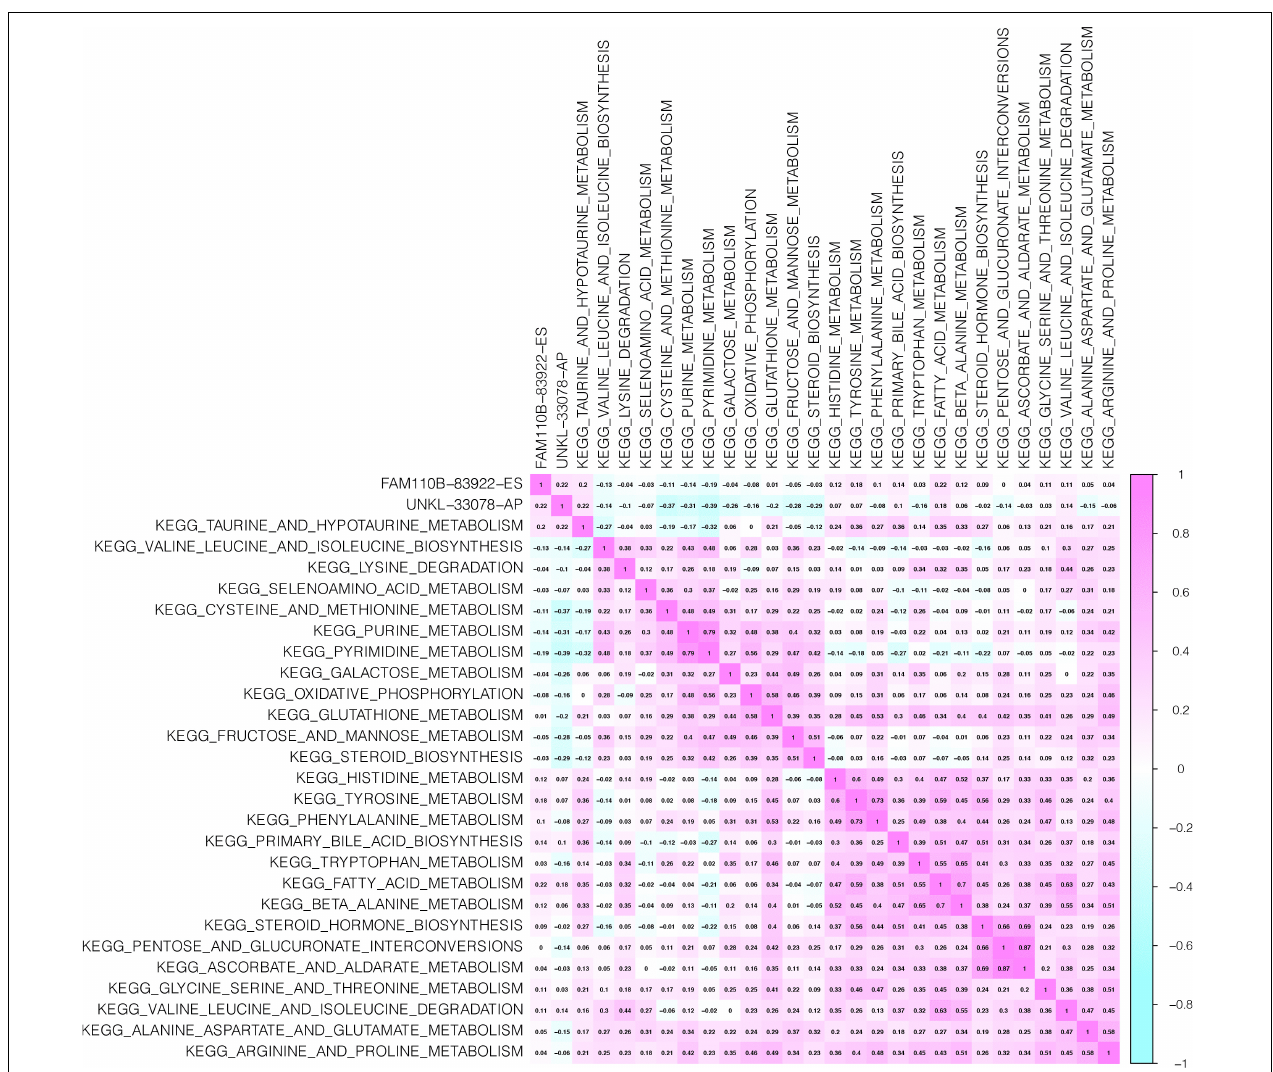
FIGURE 6 | CorHeatmap of KEGG Pathways and Selected ASEs. The aim of this plot is to find out pathways correlated to overall-survival-associated splicing events associated with bone and distant